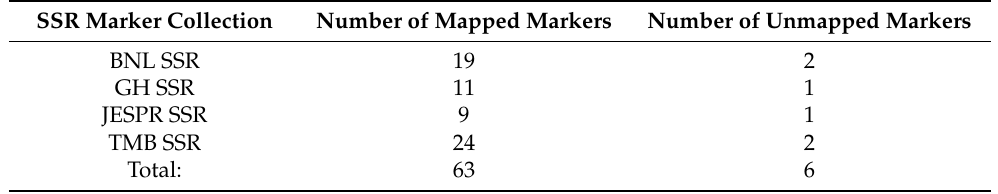
Table 3. Sets of mapped and unmapped SSR markers.